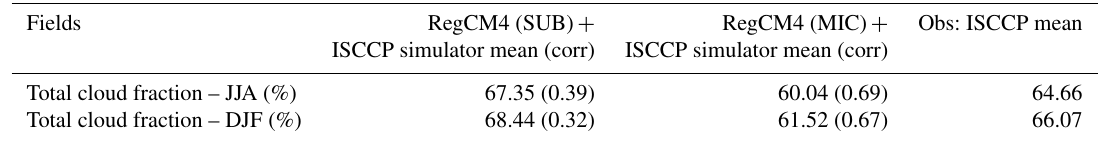
Figure 3. RegCM4 simulations using the ISCCP simulator using the SUB scheme for DJF (a) and JJA, and using the MIC scheme for DJF (c) and for JJA (d) . Satellite observations of ISCCP total cloud amounts (unit in %) for JJA (a) and DJF (c) . Table 2. Global means (and spatial correlations with observations) of total cloud fractions for JJA and DJF 2007 of SUB and MIC vs.